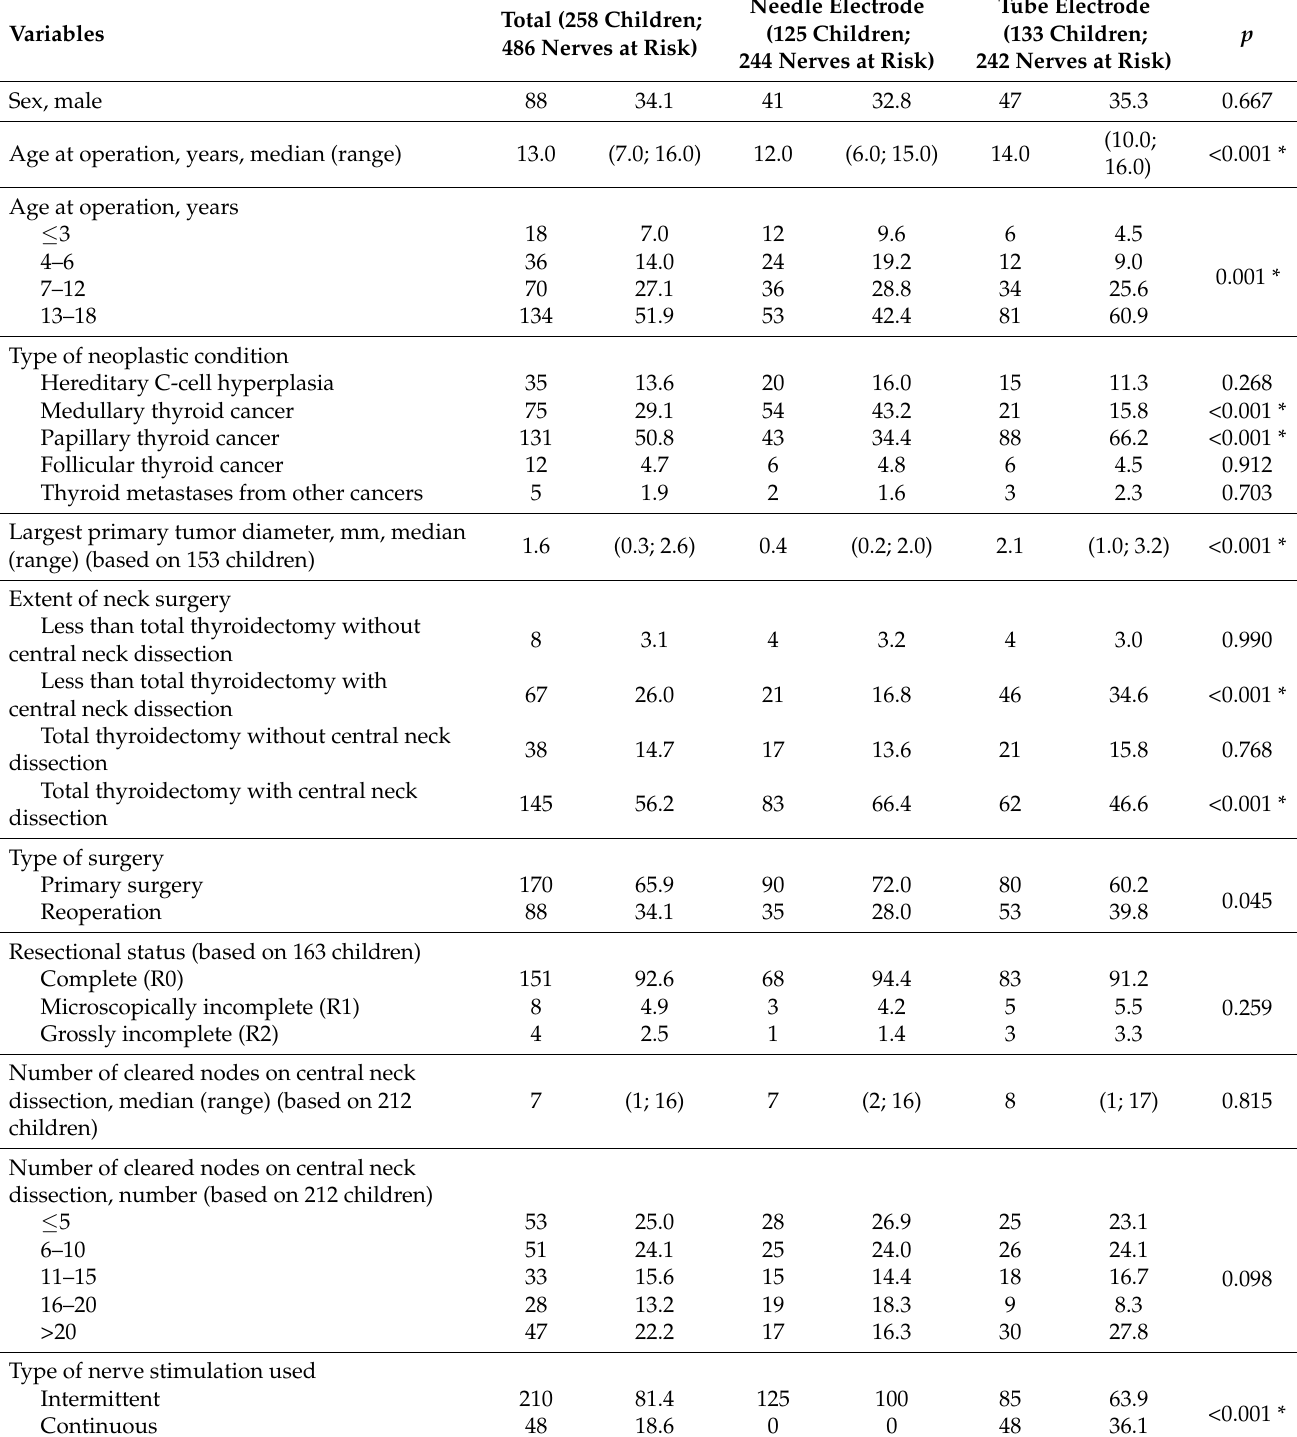
Table 2. Demographics, thyroid histopathology, extent, type, and completeness of pediatric oncological thyroidectomy by type of recording